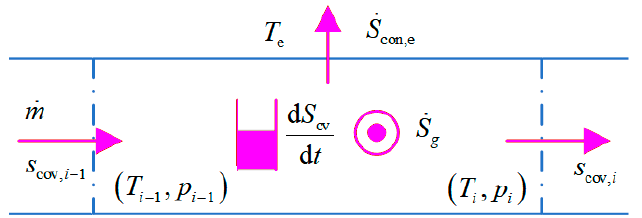
Figure 4. Schematic diagram of energy balance of finite element control volume.